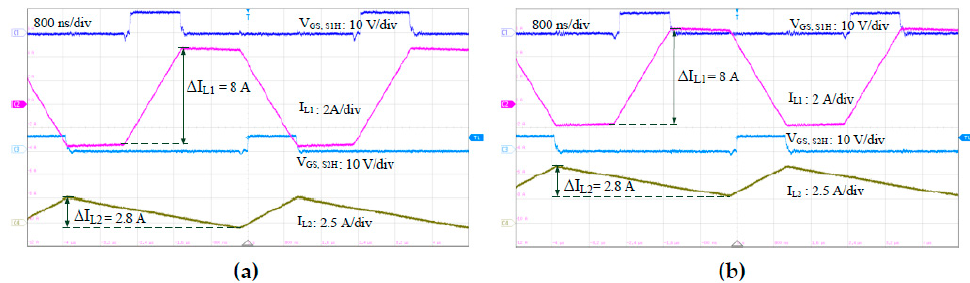
Figure 11. Inductor current waveforms in the forward direction with fixed switching frequency at 200 kHz: ( a ) at 20% load; ( b ) at 60% load.